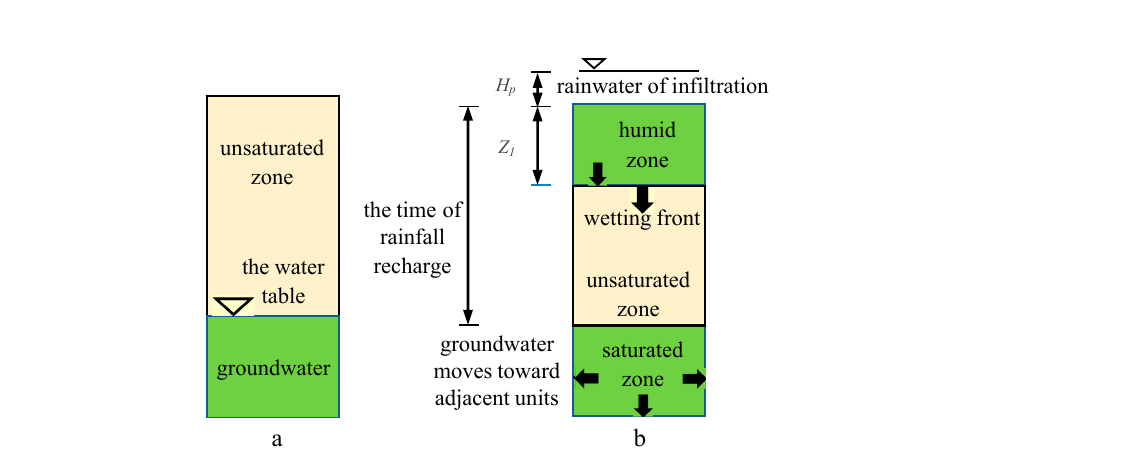
Figure 5. Sketch map of groundwater flow.